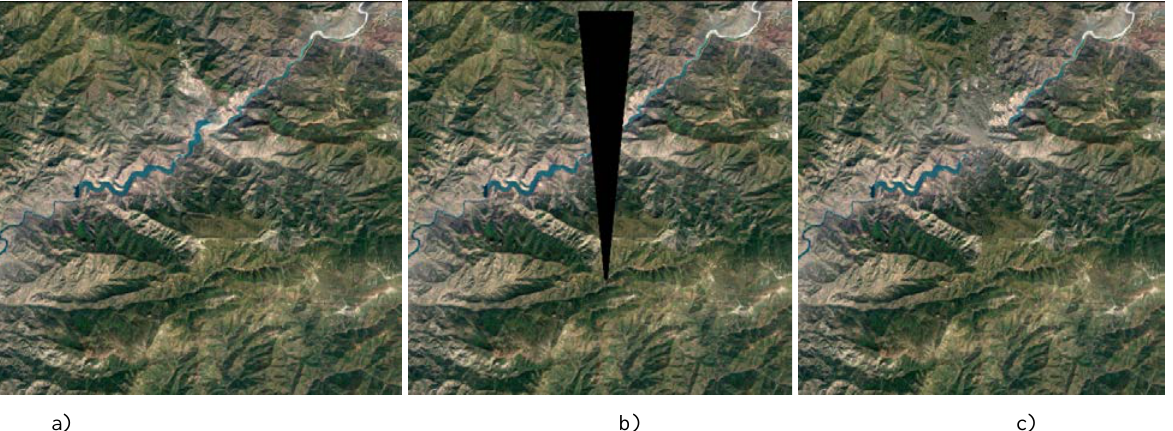
Fig. 4 . The result of the method: a) original image , b) the image, with a mask of the distorted pixels, c) image, reconstructed by the proposed method.